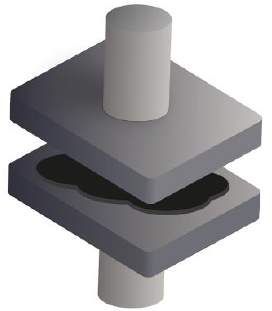
Figure 2. Preparation of a solid polymer electrolyte by the hot-pressing method. High temperature and high pressure are required to shape the membrane.